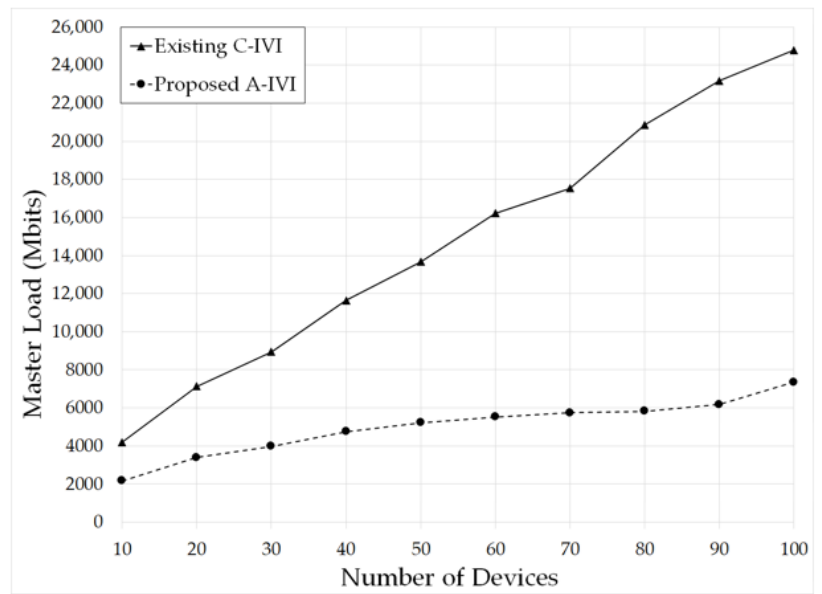
Figure 29. Master load for different number of devices.